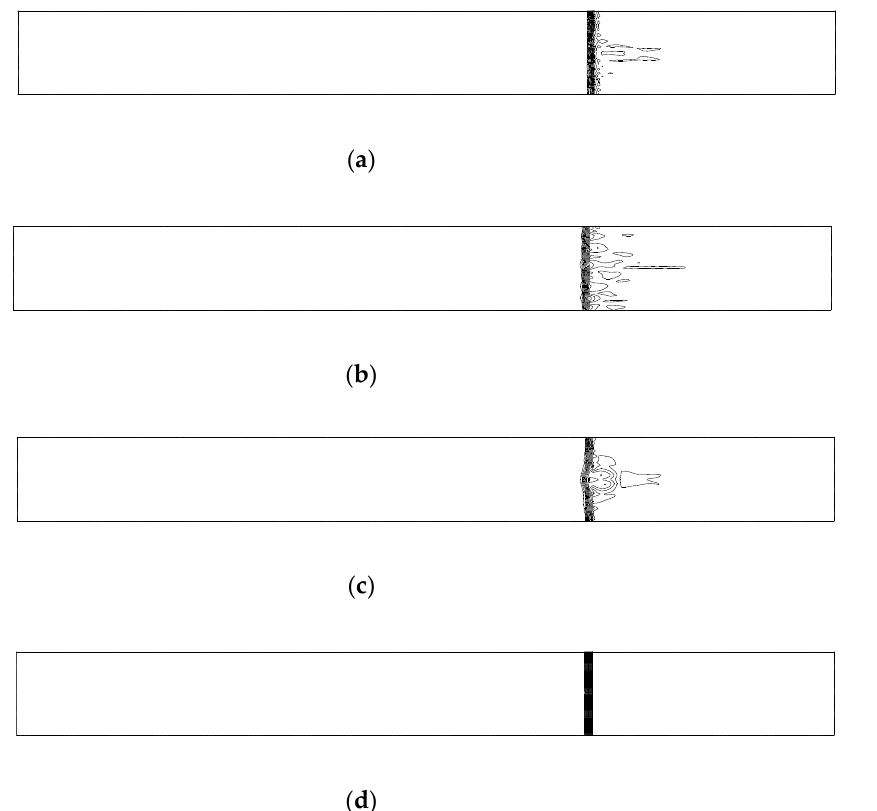
Figure 16. Density contours of the odd – even grid perturbation problem ( M s = 6.0, first order recon- struction,